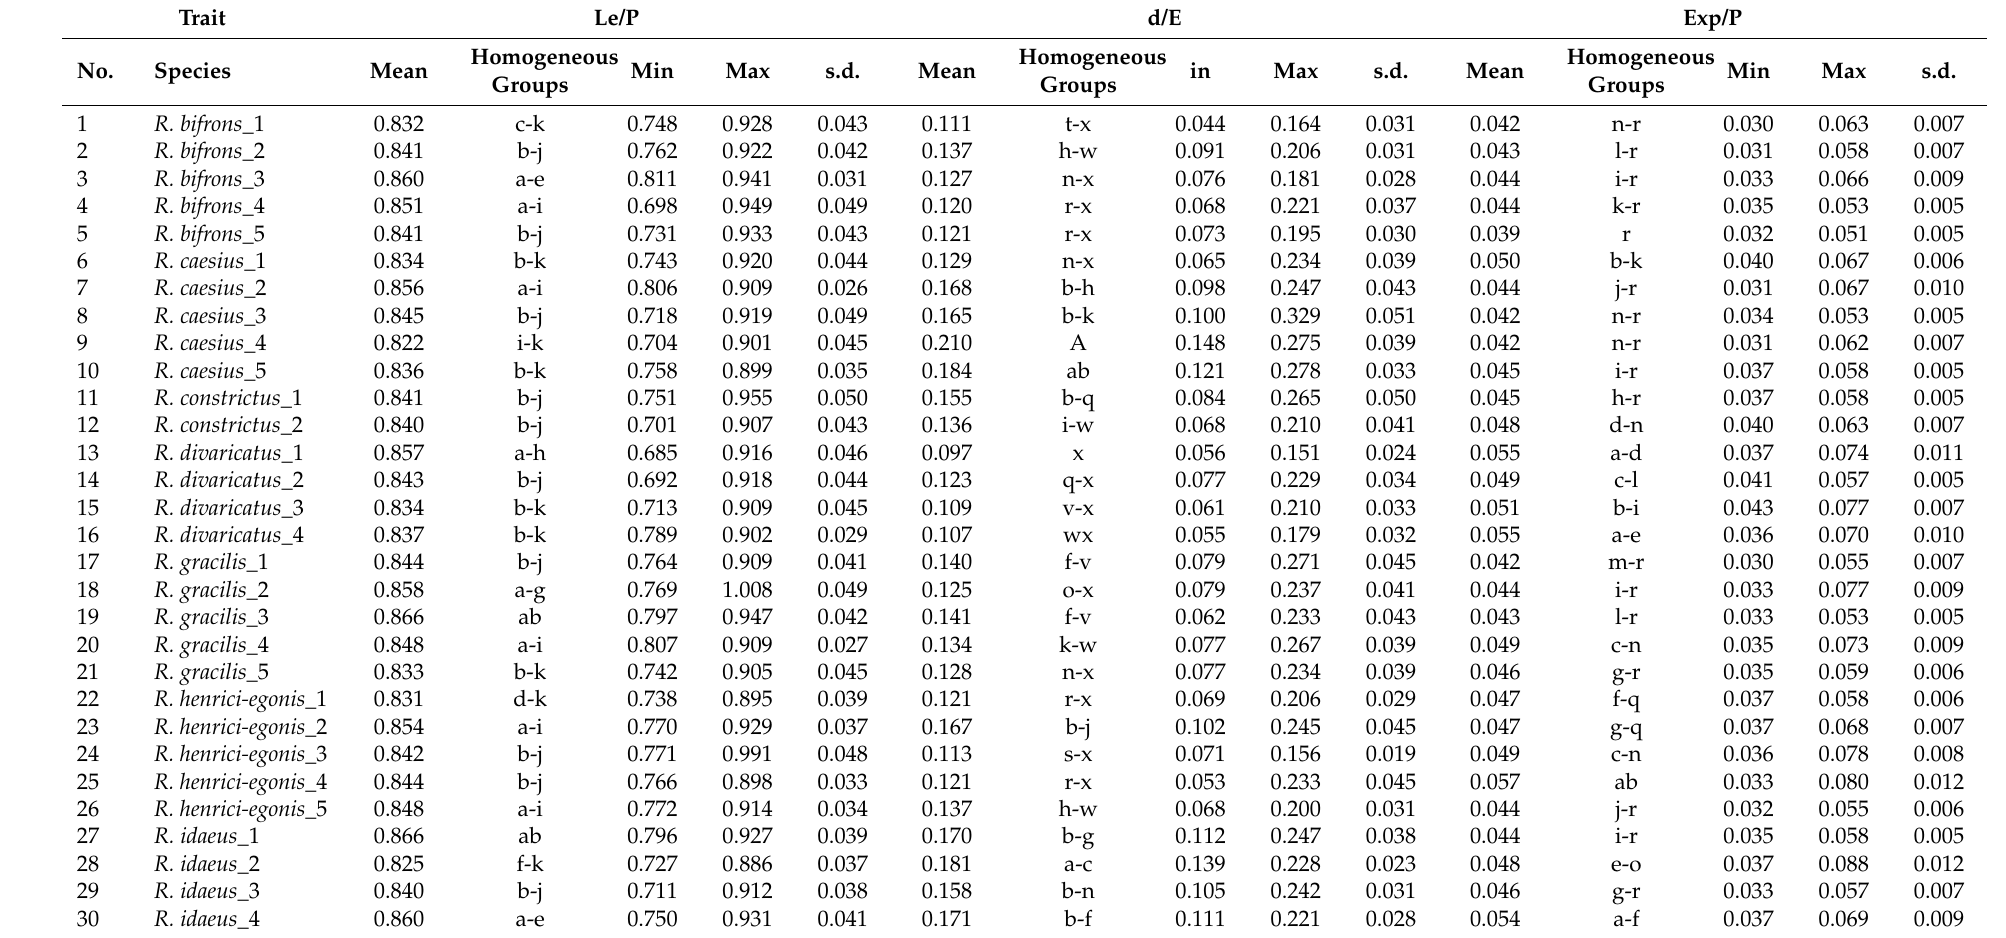
Table 5. Mean, minimal and maximal values as well as standard deviations (s.d.) for Le/P, d/E and